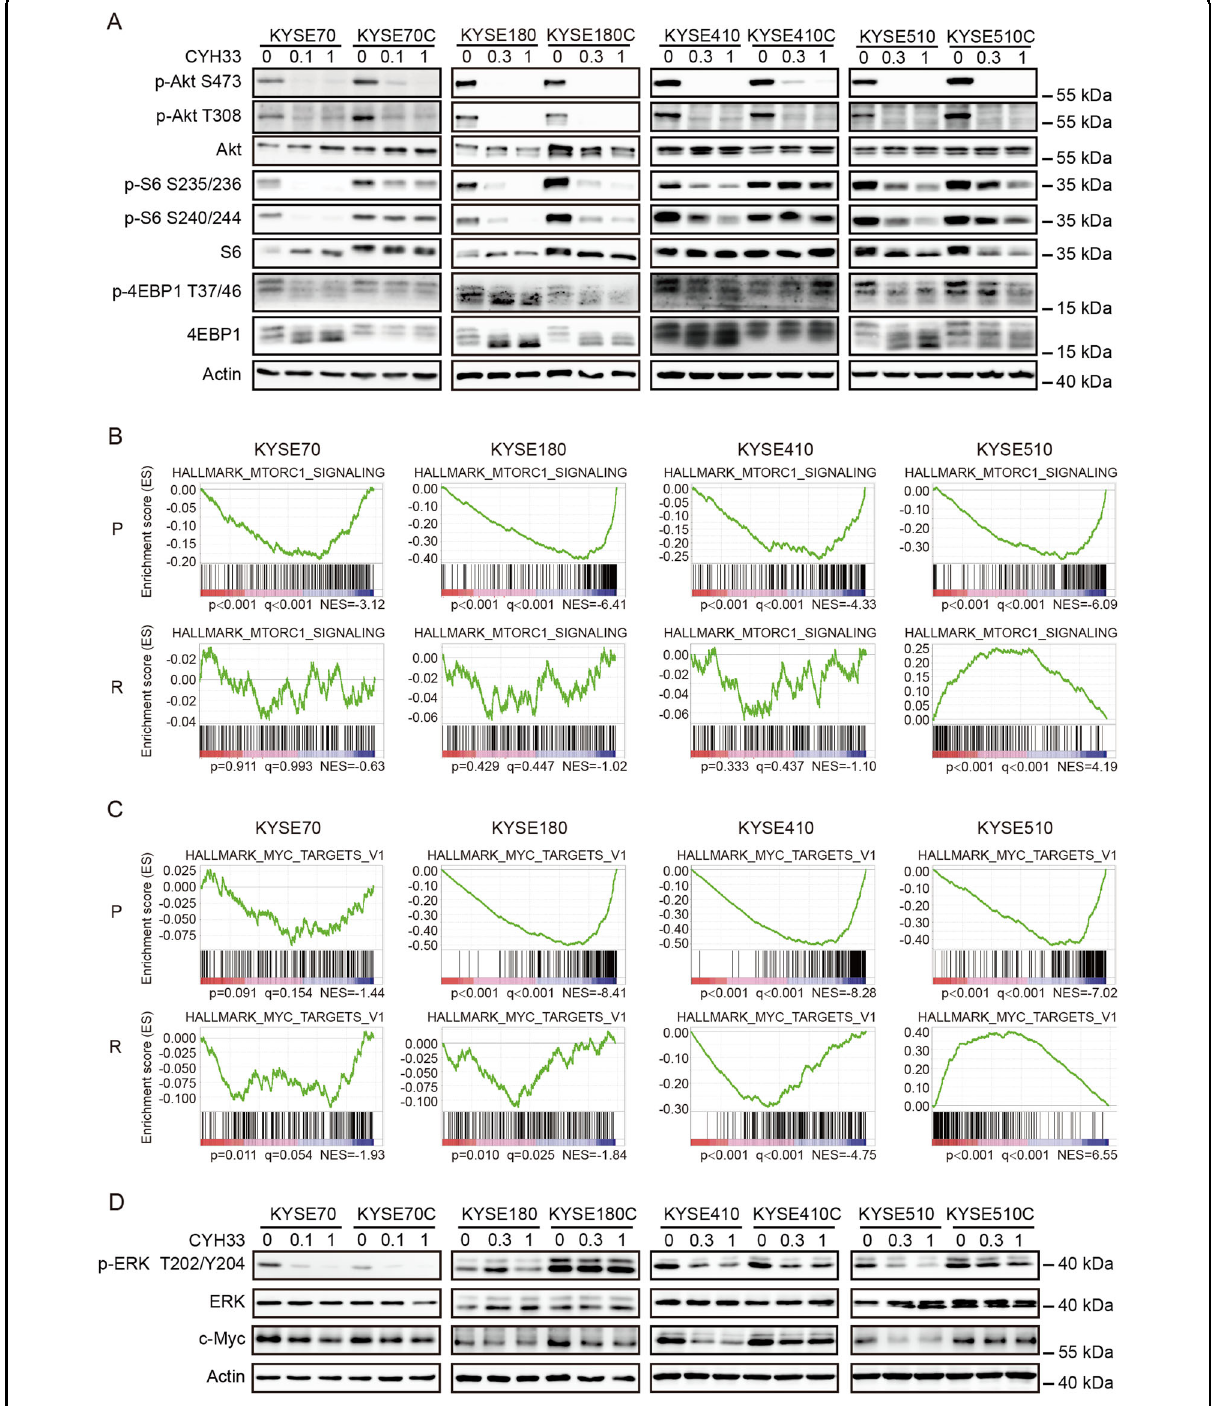
Fig. 3 Acquired resistance to PI3K α inhibition in ESCC cells was associated with hyper-activation of mTORC1, MAPK, and c-Myc. A Parental and resistant cells were treated with CYH33 at the indicated concentrations for 1 h. Cell lysates were subjected to western blotting with indicated antibodies. B , C CYH33-resistant and parental cells were treated with 1 μ M CYH33 or DMSO for 24 h and RNA was puri fi ed and subjected to RNA sequencing. GSEA enrichment plot of differentially expressed genes in the gene set of mTORC1 signaling pathway (HALLMARK_MTORC1_SIGNALING) ( B ) and MYC targets (HALLMARK_MYC_TARGETS_V1) ( C ) upon CYH33 treatment in CYH33-resistant cells and parental cells. D CYH33-resistant cells and parental cells were treated with CYH33 at indicated concentrations for 1 h. Cell lysates were subjected to western blotting with indicated antibodies. Data shown are from three replicates or three independent